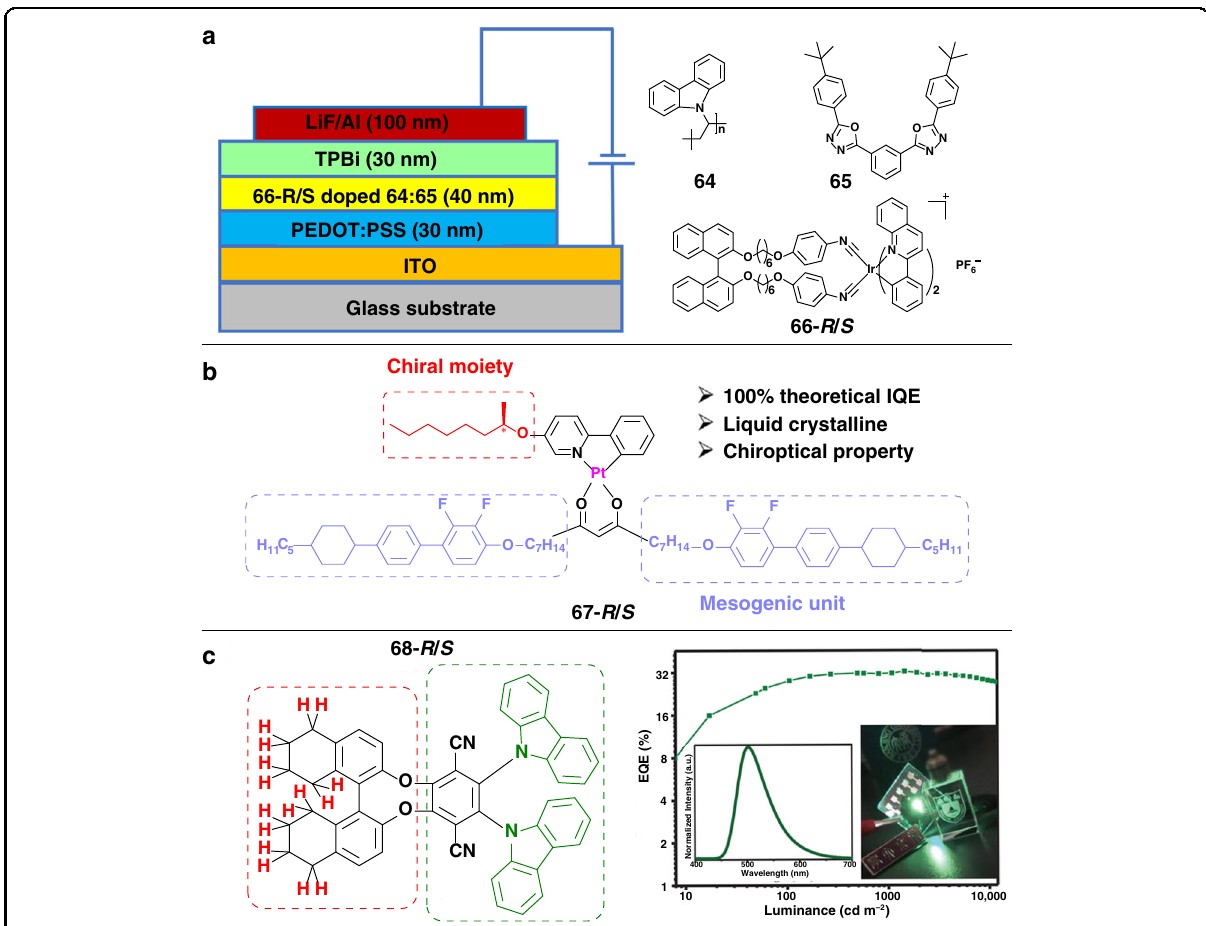
Fig. 8 Applications in CP-OLEDs. a The device con fi guration and chemical structures of the chiral Ir(III) complexes. b Molecular structure of Pt(II) complexes composed of liquid crystalline moiety and chiral moiety. c Chemical structures of the TADF molecules and corresponding EQE-luminance curves of the CP-OLEDs. Images reprinted with permission from: a ref. 117 ; b ref. 118 ; c ref. 119 from